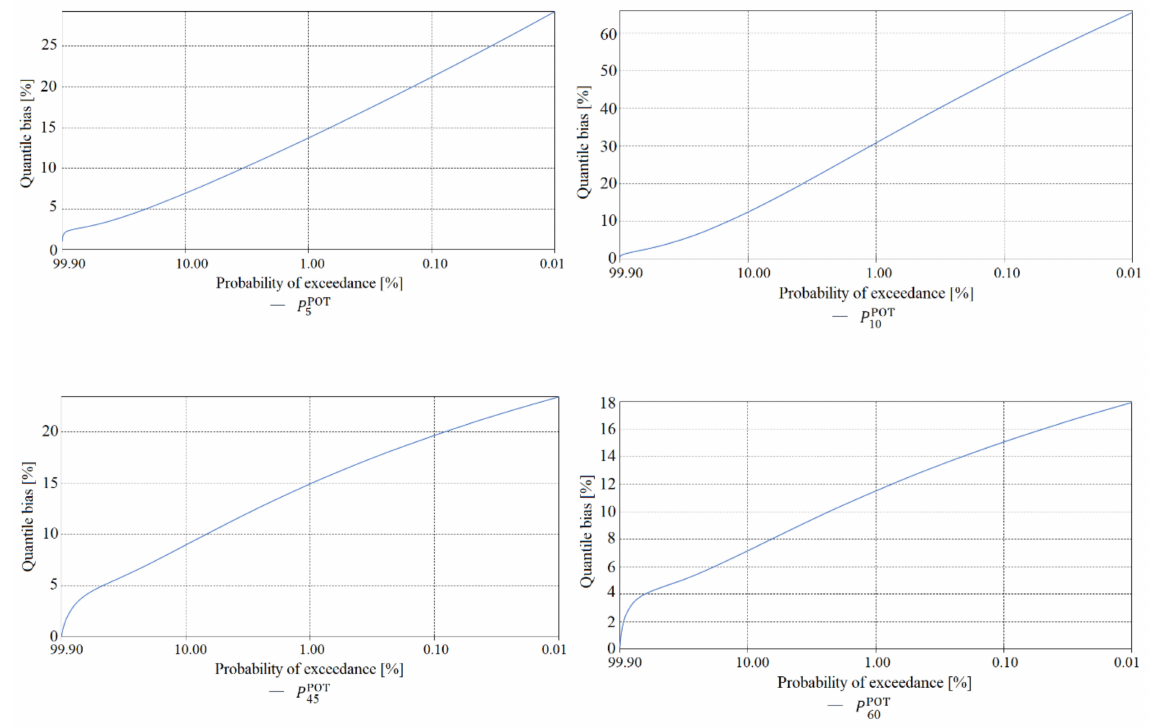
Figure 14. Comparison of estimated values of quantile error resulting from the randomness of the sample of maximum precipitations computed using the PMAXTP model for the random variable P POT τ with durations τ = {5, 10, 45, 60} min, for the Bialystok meteorological station.